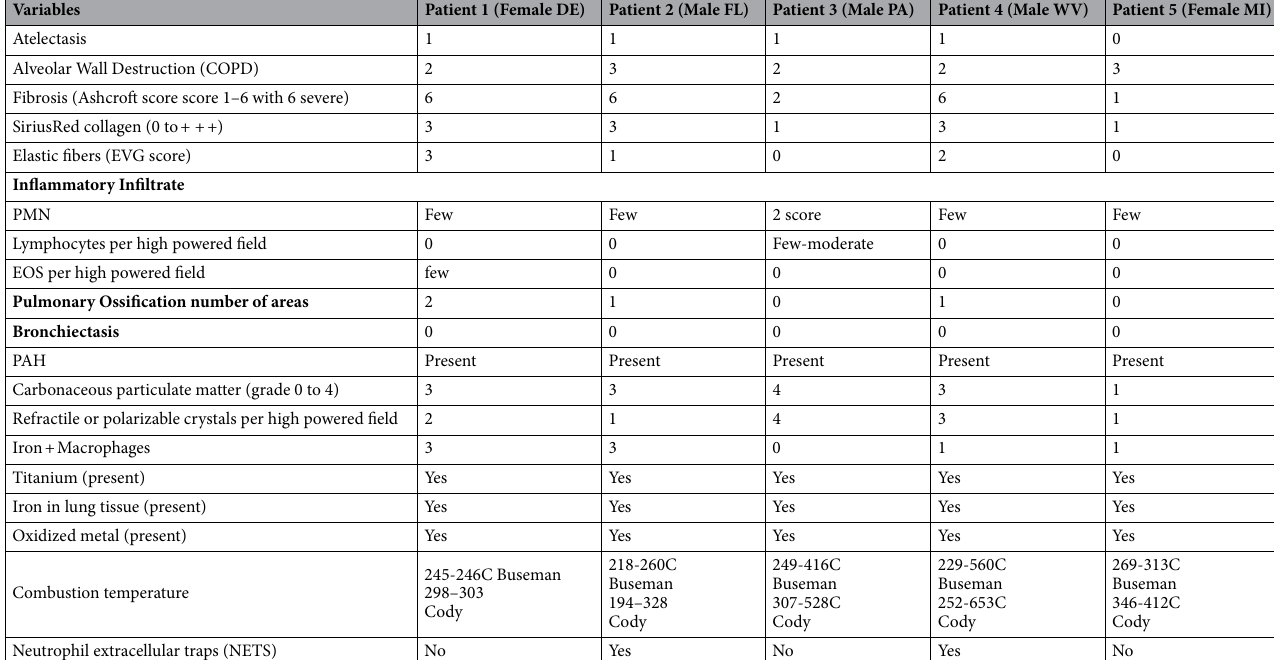
Table 3. Biopsy results for five soldiers deployed to the middle east between 2003 and